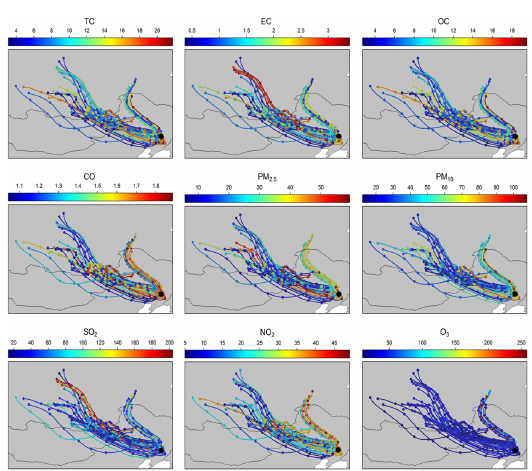
Figure A1. Back trajectory pathway among various pollutants during 72 h in the major period of the Spring Festival, local time, in Changchun (black circle).